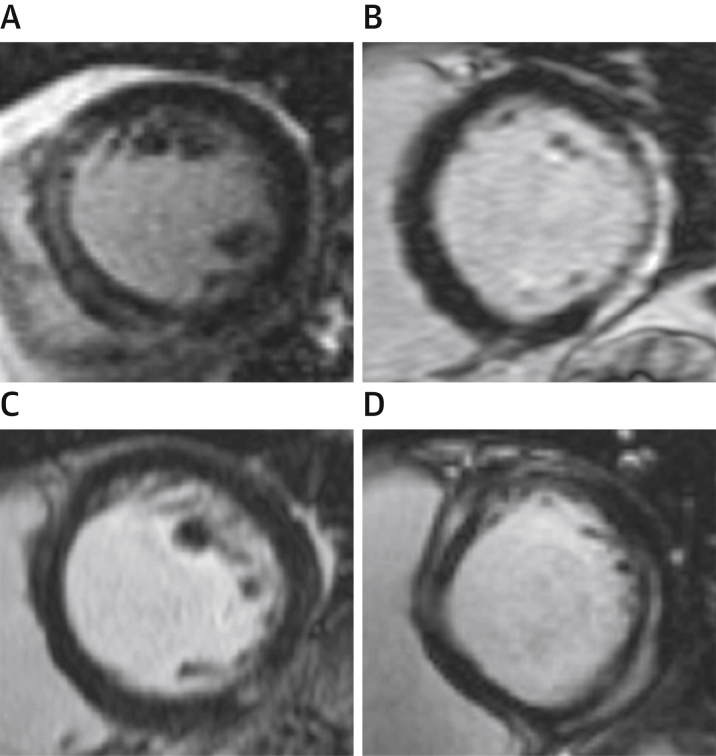
Late Gadolinium Enhancement in Dilated CardiomyopathyLate gadolinium enhancement images showing (A) linear mid-wall enhancement in the septum, (B) sub-epicardial enhancement in the lateral wall, (C) focal enhancement of the inferior wall, and (D) mid-wall enhancement of the septum, lateral and inferior wall.